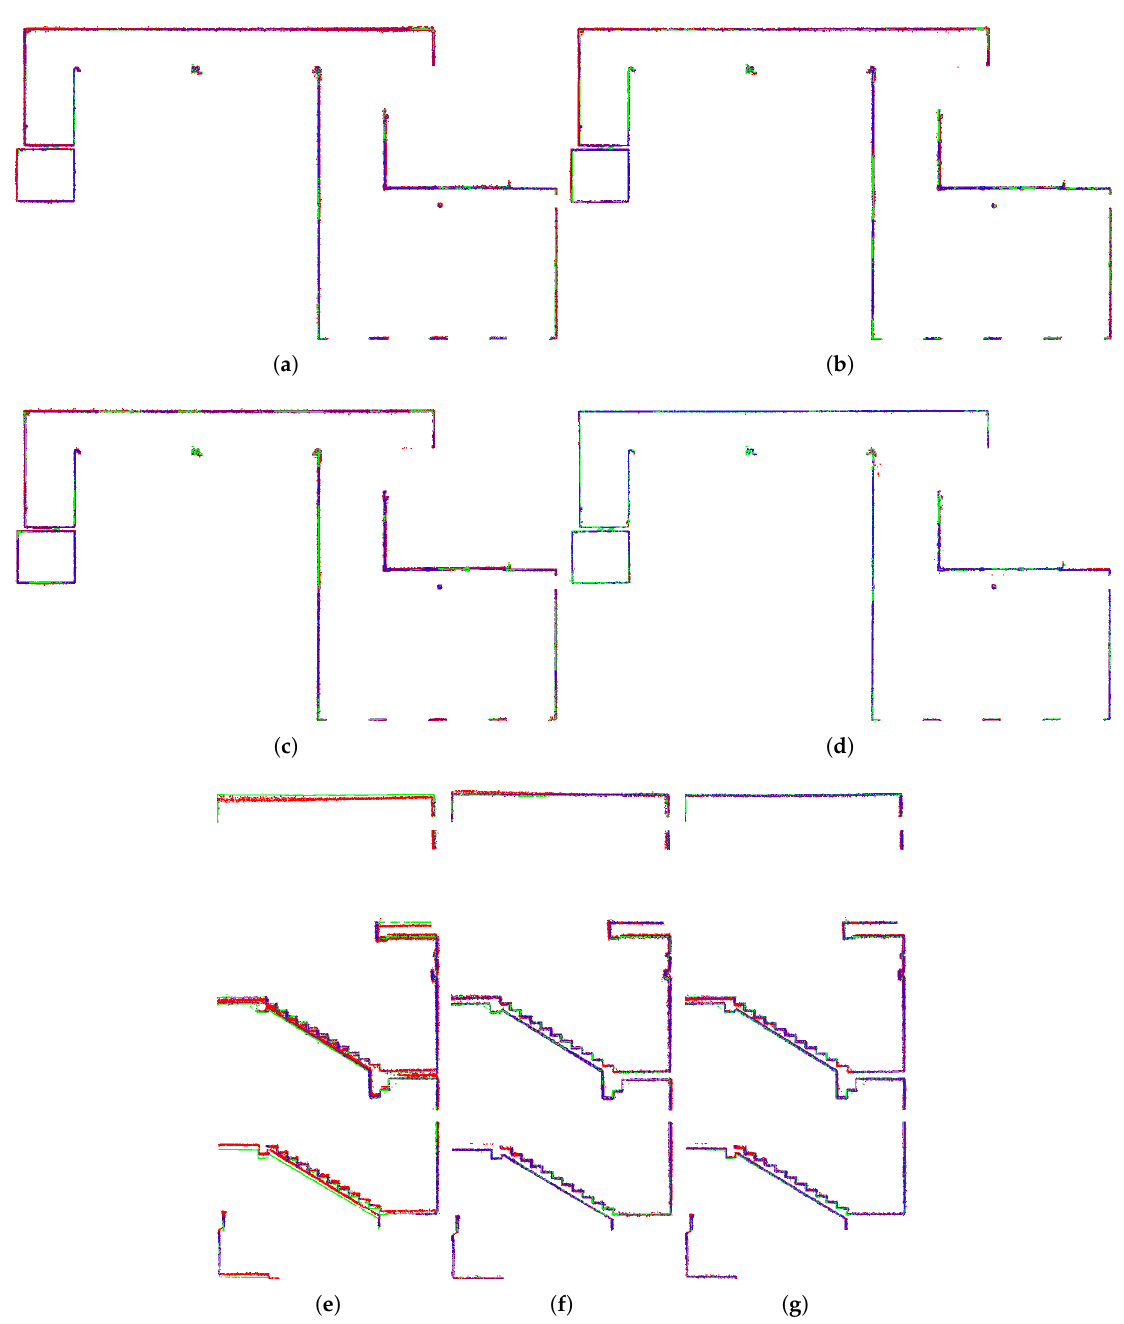
Figure 22. Color coded errors within the horizontal reference slice of the Office dataset ( a )–( d ) and vertical slice in Staircase dataset ( e )–( g ). Blue color represents zero error, red color stands for 10 cm error and higher. The ground truth FARO data are displayed in green. The results are provided for 4RECON-10 ( a , e ), 4RECON-overlap ( b , f ), 4RECON-verification ( c , g ), and ZEB-1 ( d ). For Office dataset, there are no ambiguities (double walls) even without visual loop detection while both loop closure and pose graph verification is necessary for more challenging Staircase dataset to discard such